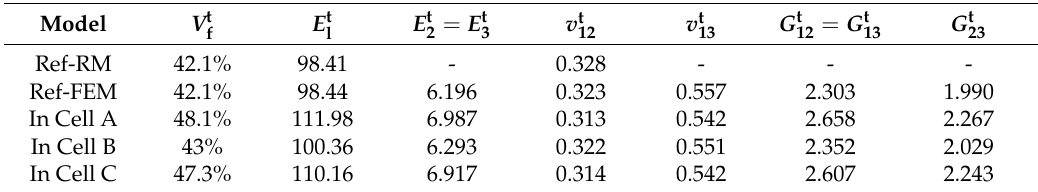
Table 4. The engineering constants of the composite tows with different fiber volume fraction obtained using micromechanical